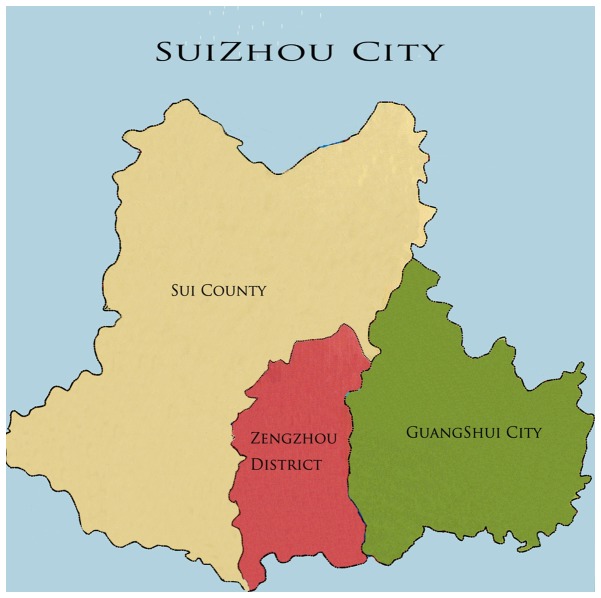
Suizhou City Map.